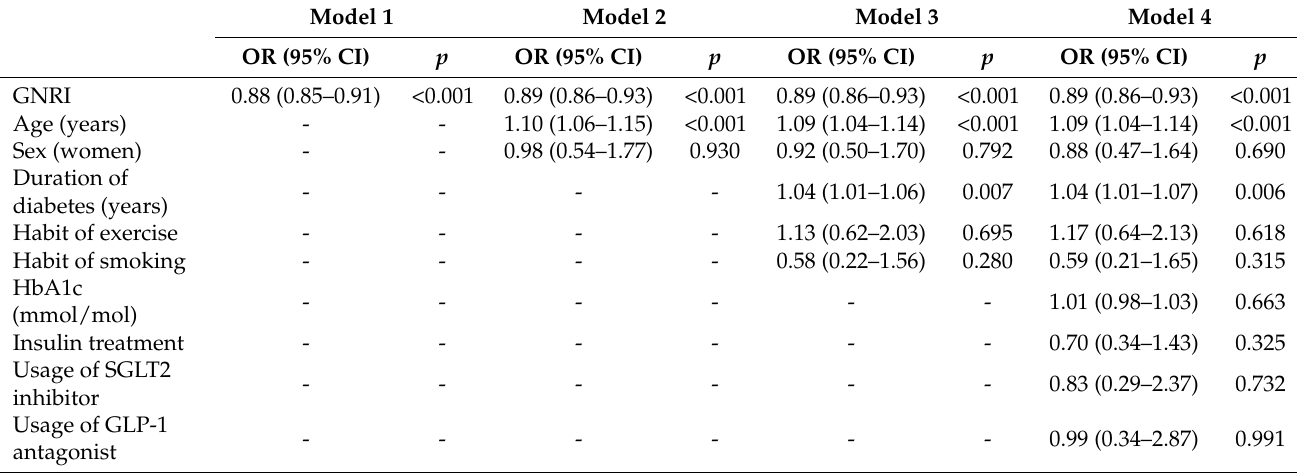
Table 4. Odds ratio of the continuous geriatric nutritional risk index on the presence of sarcopenia. Model 1 Model